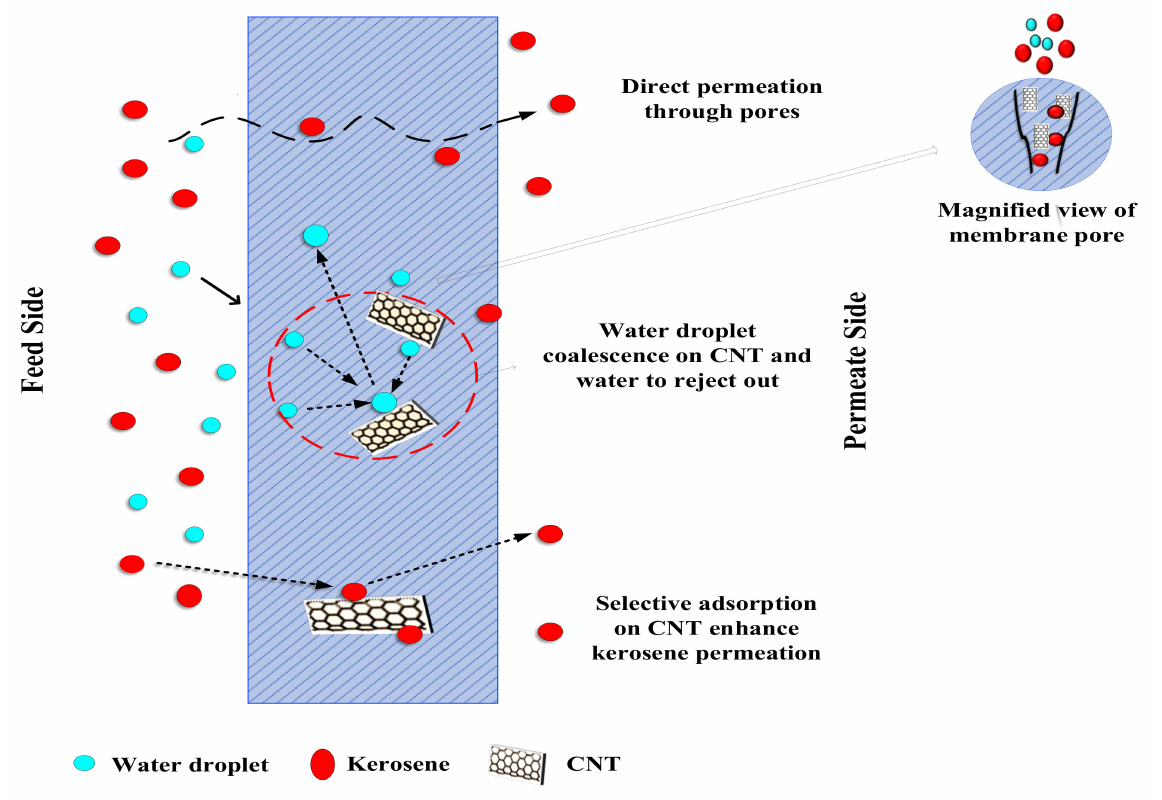
Figure 6. Dewatering mechanism by